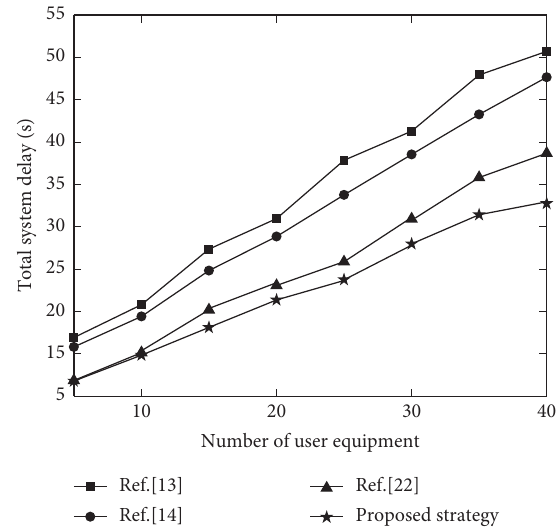
Figure 5: Relationship between time delay and the number of user equipment under different strategies.